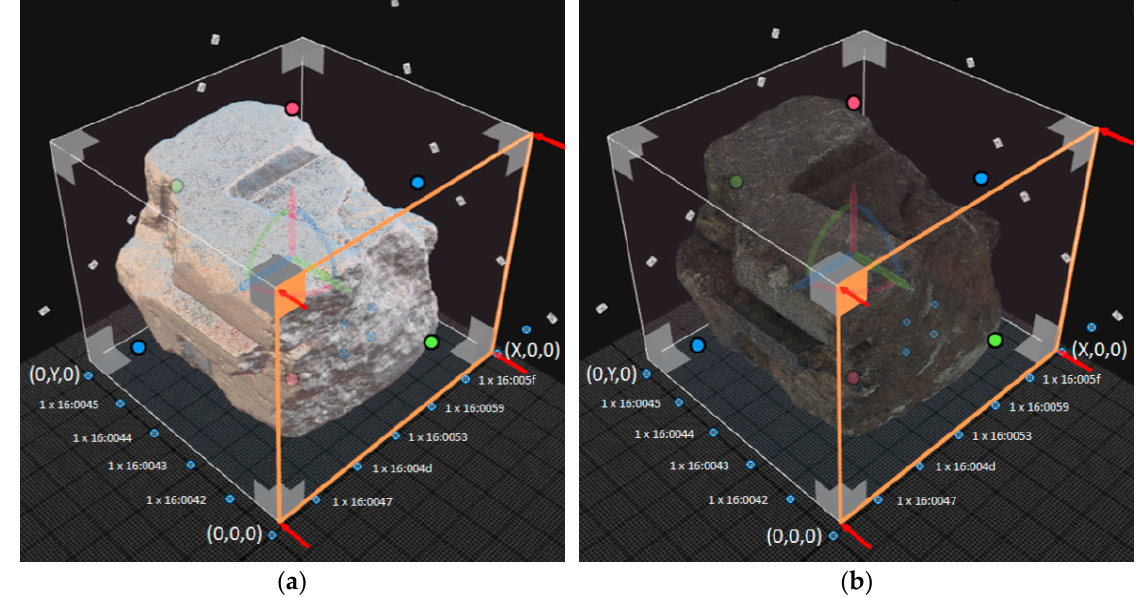
Figure 5. Screenshots of Narbolia mould (N1) and reconstruction region (RR) with L-shape Reference System (LRS) on RC: ( a ) point cloud model, ( b ) textured model.